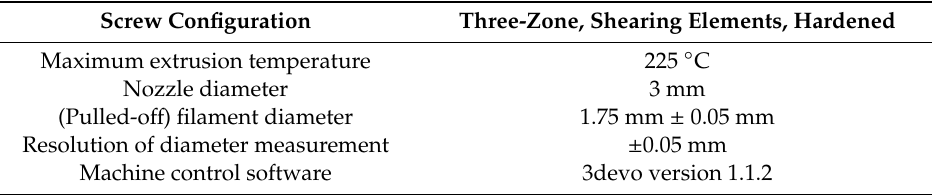
Table 3. 3devo filament extruder specifications